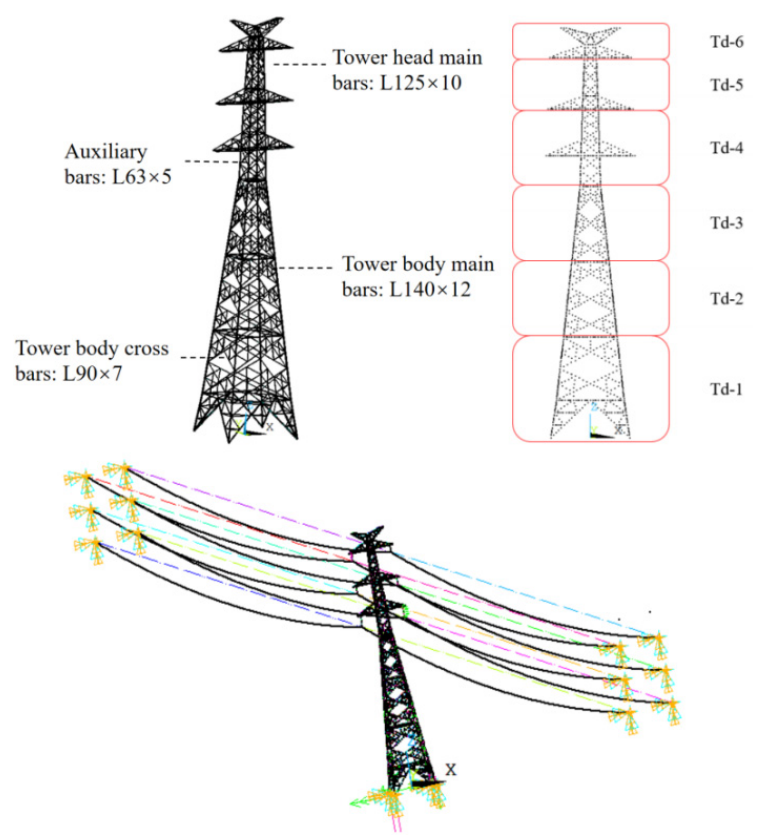
Figure 4. The tower-line coupled simulation model.